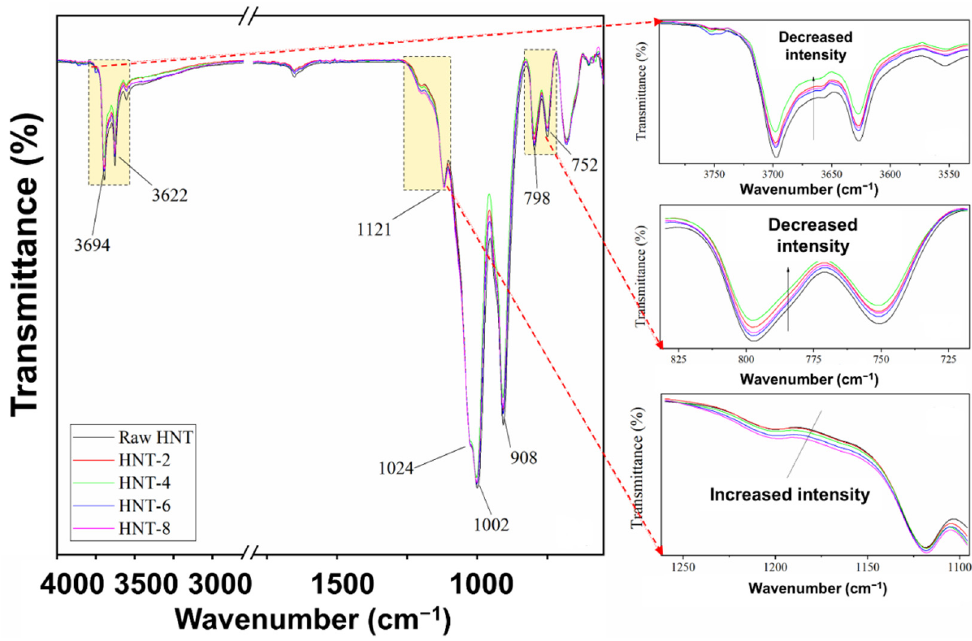
Figure 3. Infrared spectra of HNT powder after various durations of acid treatment.